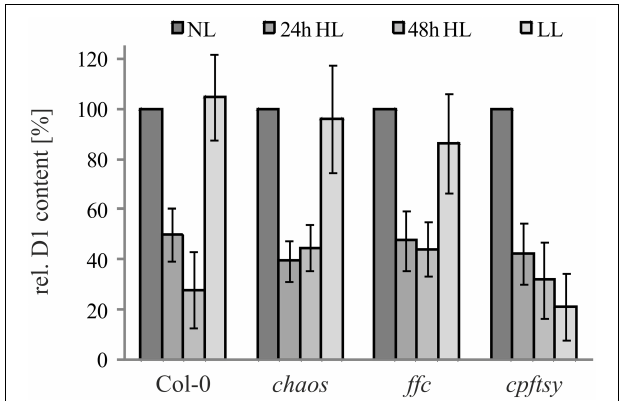
FIGURE 1 | D1 level in cpSRP mutant plants under high light conditions and a subsequent recovery phase. Wild type and cpSRP mutant plants were raised at normal light conditions (NL, 120 µ mol photons m − 2 s − 1 ) to rosette stage and then exposed to high light (HL, 1000 µ mol photons m − 2 s − 1 ) for 24 or 48h. Subsequently, plants were exposed to low light for 48h (LL, 50 µ mol photons · s − 1 · m − 2 ). Total protein extracts from 100mg fresh weight of intact and fully expanded leaves were prepared after each light treatment and used for immunodetection of D1. The signals of the D1 immunoblots were quantified using the ImageJ program. The D1 levels in normal light conditions were set to 100%. Error bars indicate the standard deviation ( n = 4 ).